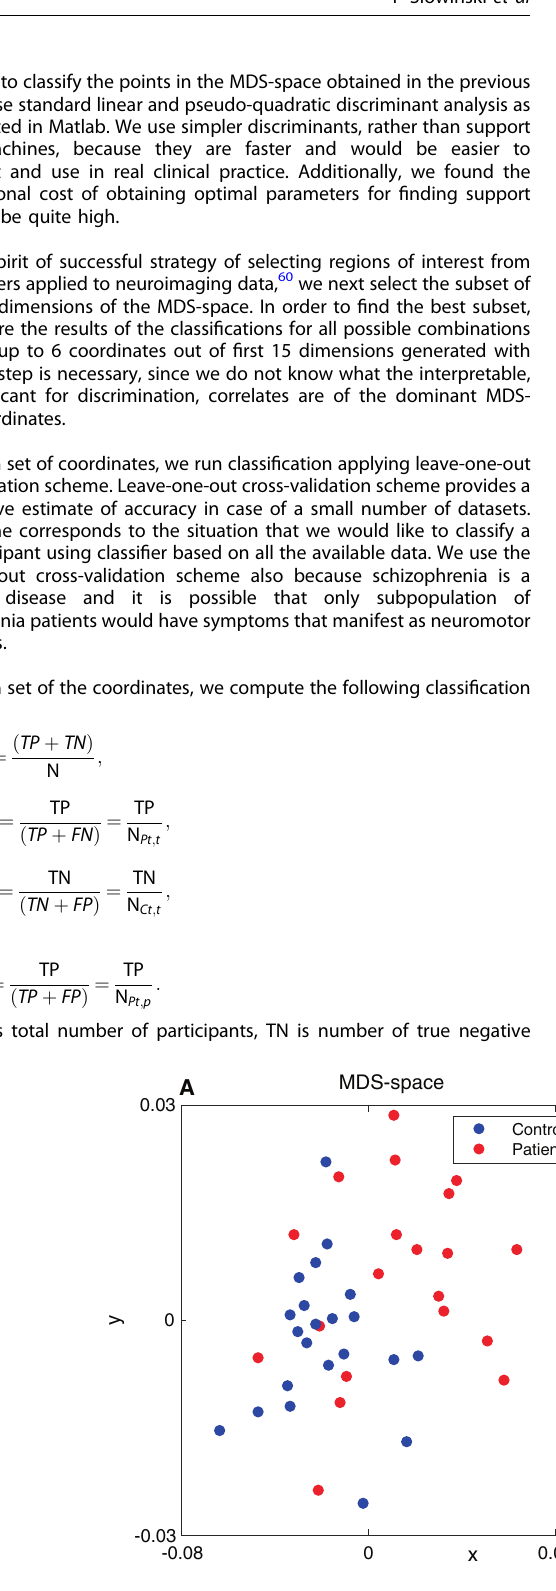
Fig. 4 Illustrative example of the MDS-space and of the Step 7 of the classi fi cation algorithm. a Two fi rst coordinates of the MDS-space computed from the EMDs between distributions of absolute phase lag over frequencies | ϕ r (f) | . Red dots indicate patients while blue dots indicate controls. Corresponding classi fi cation measures are: accuracy = 0.7727, sensitivity = 0.7272, speci fi city = 0.8181, precision = 0.8000. Panel b shows accuracy and c precision of classi fi cation as a function of number of the coordinates. Black crosses show result of classi fi cation using the fi rst n dominant coordinates. Green circles show result of the best classi fi cation using the set of n coordinates out of 15 dominant